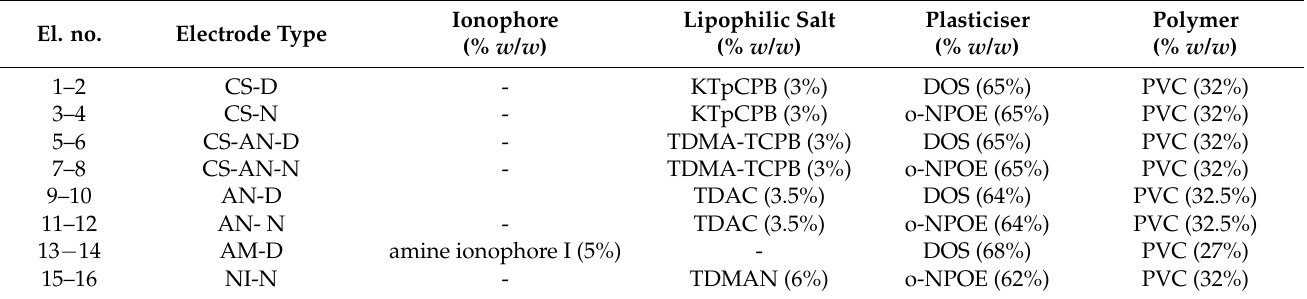
Table 2. Composition of sensor array of the electronic